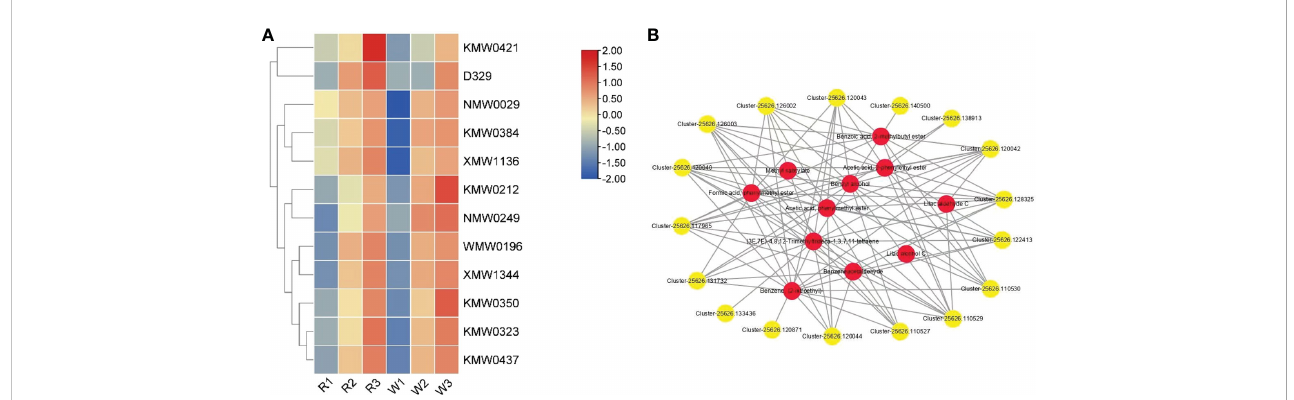
FIGURE 7 (A) Accumulation patterns of the 12 volatile organic compounds (VOCs) in Macadamia integrifolia fl owers at the R1, R2, R3, W1, W2, and W3 stages (R and W refer to red and white nut fl owers, respectively). The red and blue colors represent up-accumulated and down-accumulated VOCs, respectively. (B) STRING network analysis of the differentially expressed genes (DEGs) with shared differentially accumulated VOCs in nut fl owers. The correlation in each gene and related VOCs was greater than 0.8. In the network diagram, yellow dots represent the key genes and red dots represent the associated VOC metabolites. The solid lines and line numbers indicate the strength of the correlation between the genes and